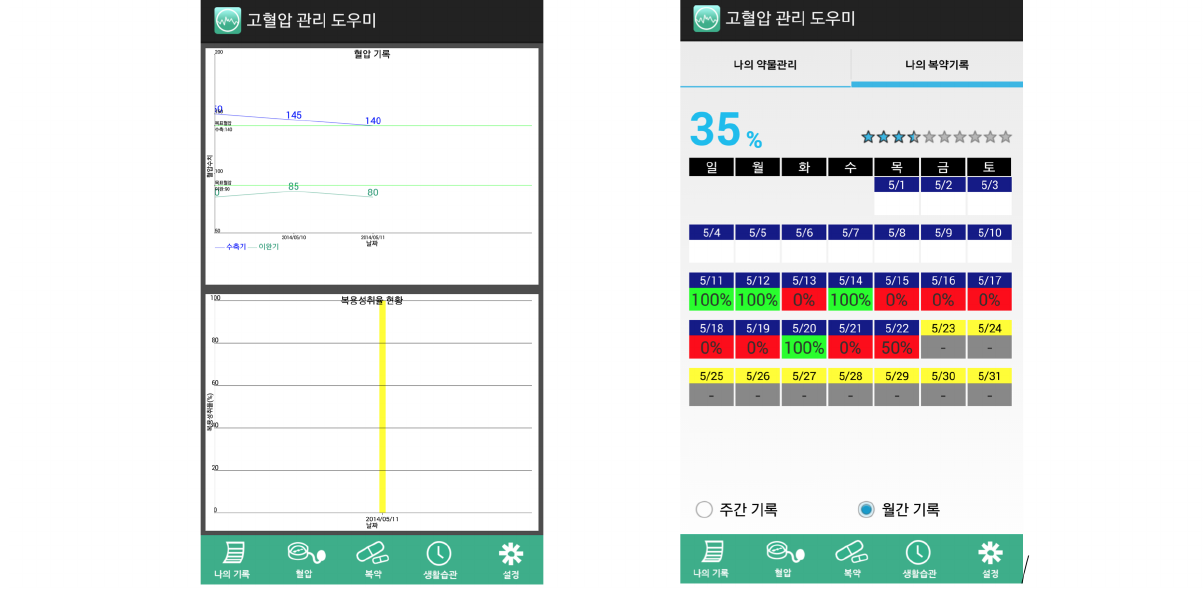
Figure 7. User interfaces of the "my records" (left) and "medication management" (right)